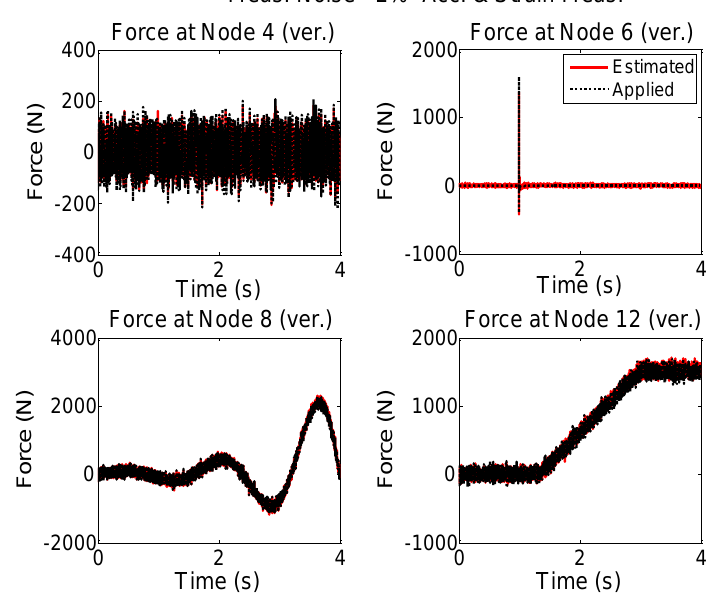
Figure 21. RMS error of estimated and applied forces for different strain gauges and accelerometer configurations on the truss structure, in presence of modeling error and measurement noises. Applied forces are dotted black line in Figure 11.